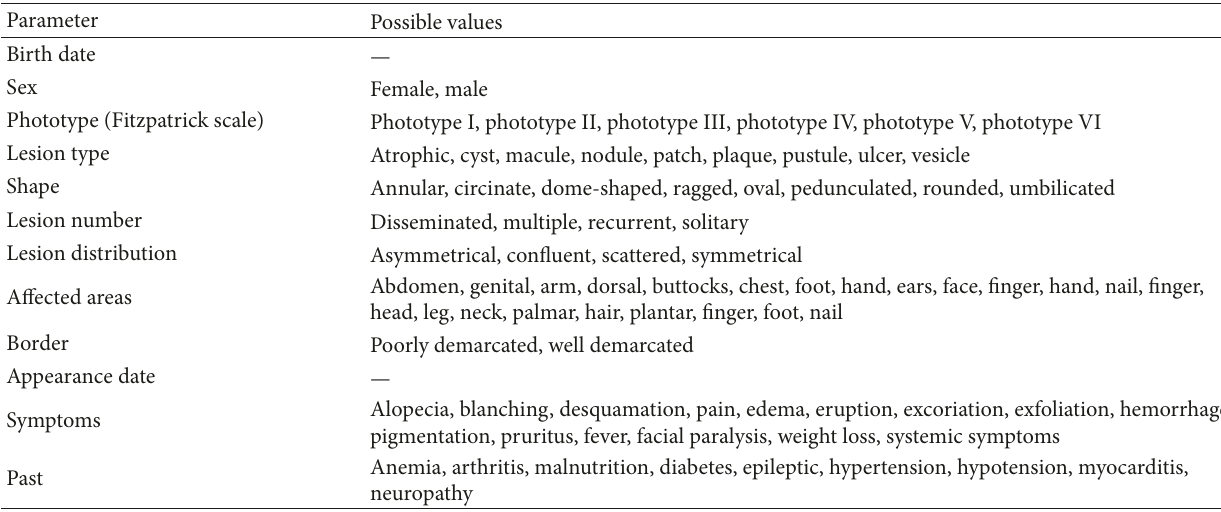
Table 1: The parameters that the application takes into account to describe dermatologic